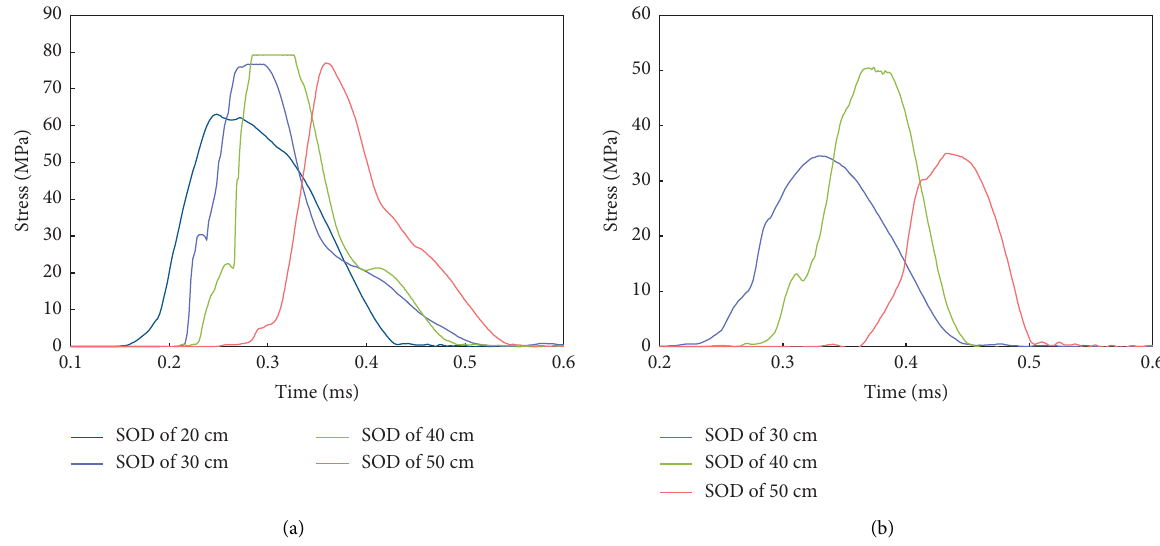
Figure 11: Stress of the concrete pile during EFP penetration with diferent SODs. (a) Depth of 400mm. (b) Depth of 575mm.